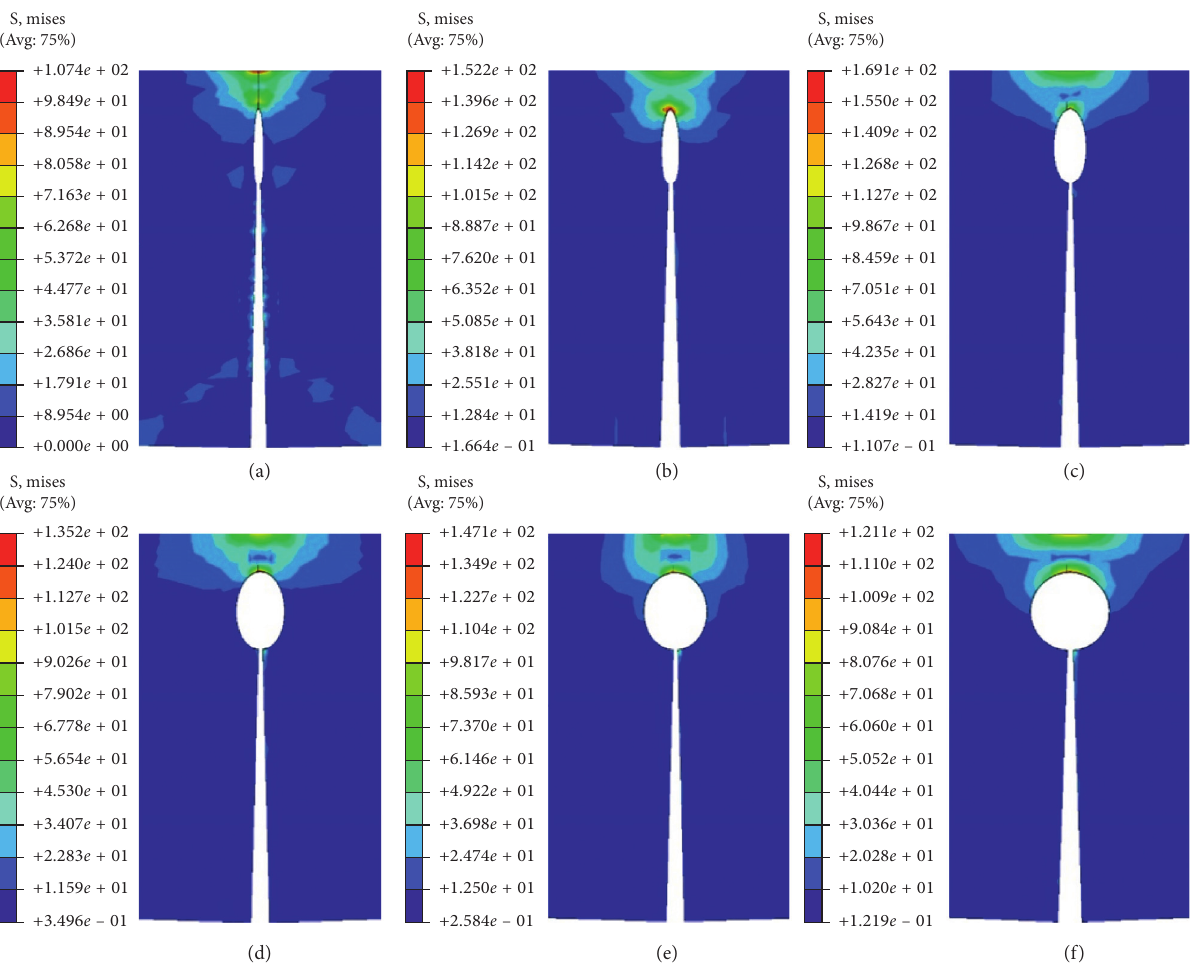
Figure 11: L1–L6 specimen von Mise stress cloud diagrams. (a) κ ( t ) � 20mm − 1 . (b) κ ( t ) � 5mm − 1 . (c) κ ( t ) � 1.25mm − 1 . (d) κ ( t ) � 0.56mm − 1 . (e) κ ( t ) � 0.31mm − 1 . (f) κ ( t ) � 0.2mm − 1